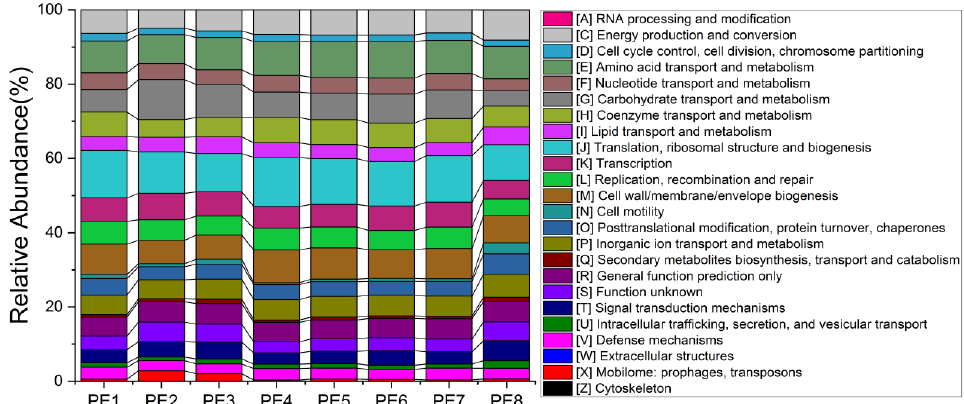
Figure 6. Functional profiles of gut microbial communities predicted by PICRUSt2; these samples were collected from eight stranded melon-headed whales (PE1-8).